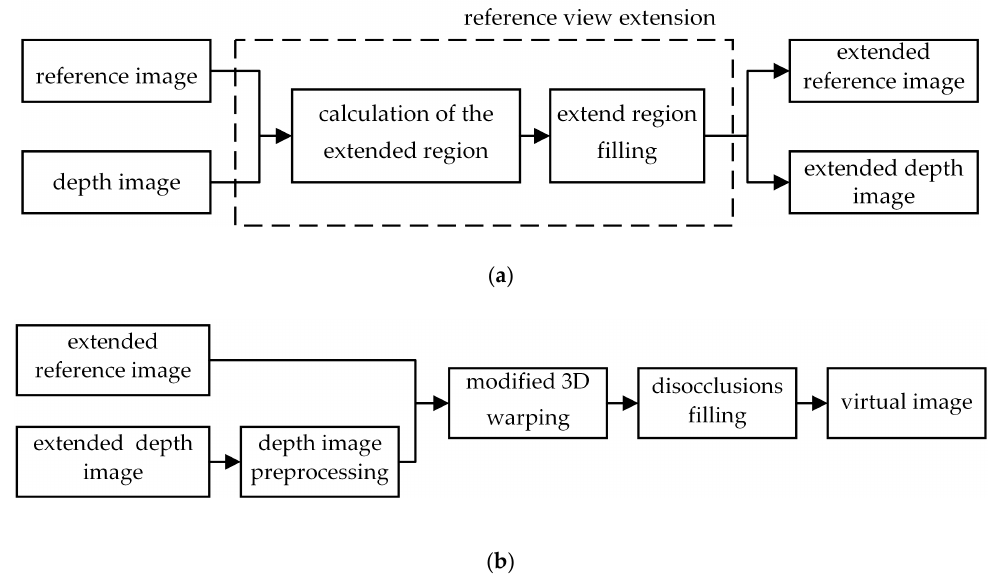
Figure 2. Framework of the proposed method: ( a ) Illustration of reference view extension; ( b ) The flow chart of proposed artifact handling approach using depth information.